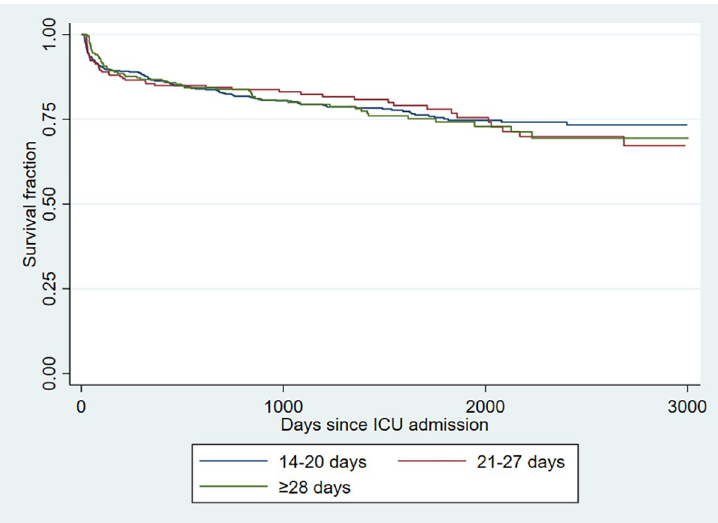
Fig 1. Kaplan-Meier survival estimates of patients admitted to intensive care units for 14–20, 21–27, and � 28 days.